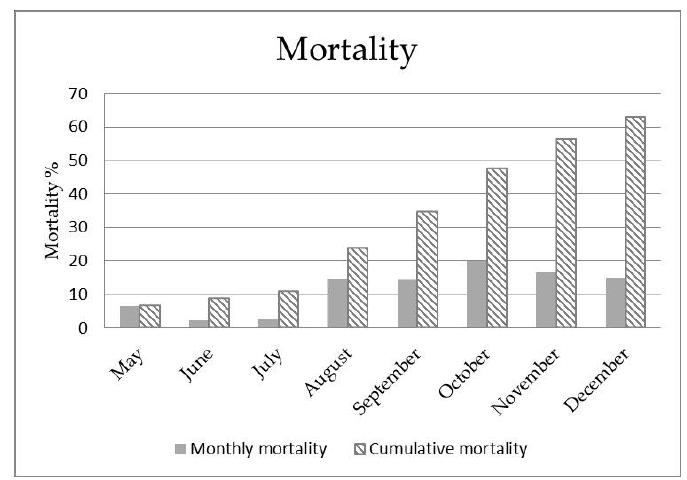
Figure 1. Monthly and cumulative mortality rates observed in Huso huso outbreak.